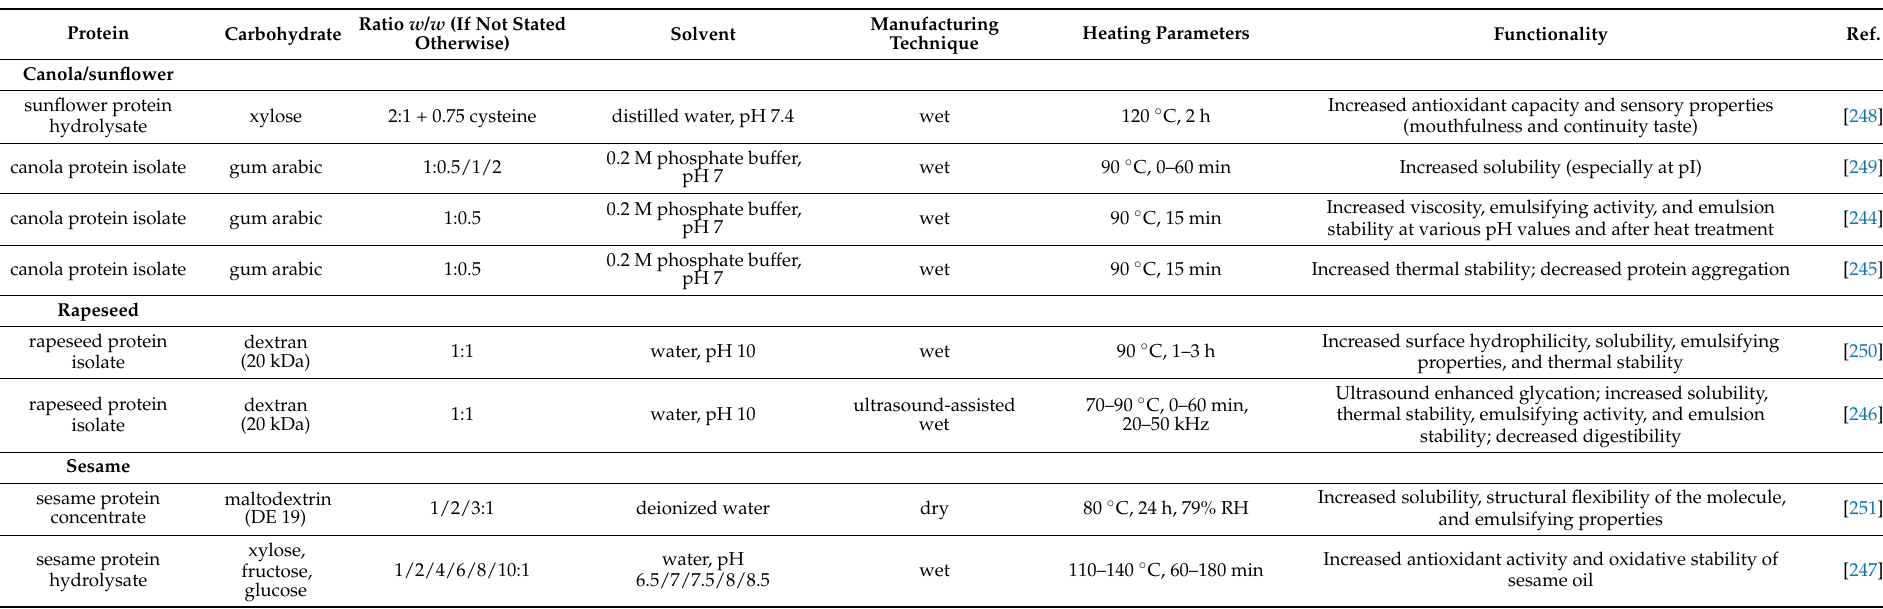
Table 3. Overview of proteins from oilseeds glycated with various carbohydrates under different reaction conditions and their functionalities. Protein Carbohydrate Ratio w / w (If Not Stated Otherwise) Solvent Manufacturing Technique Heating Parameters Functionality